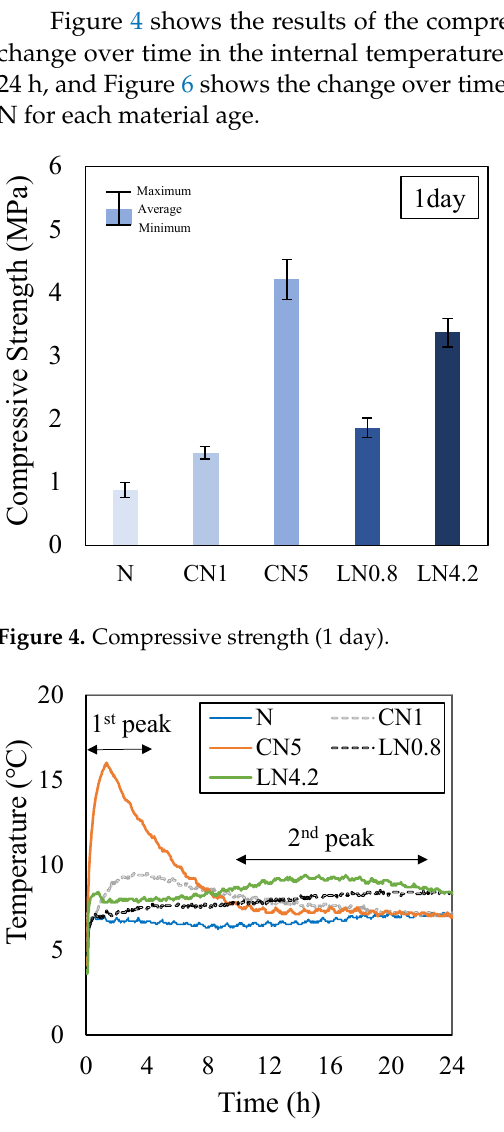
Figure 6. Change of compressive strength ratio of each age.